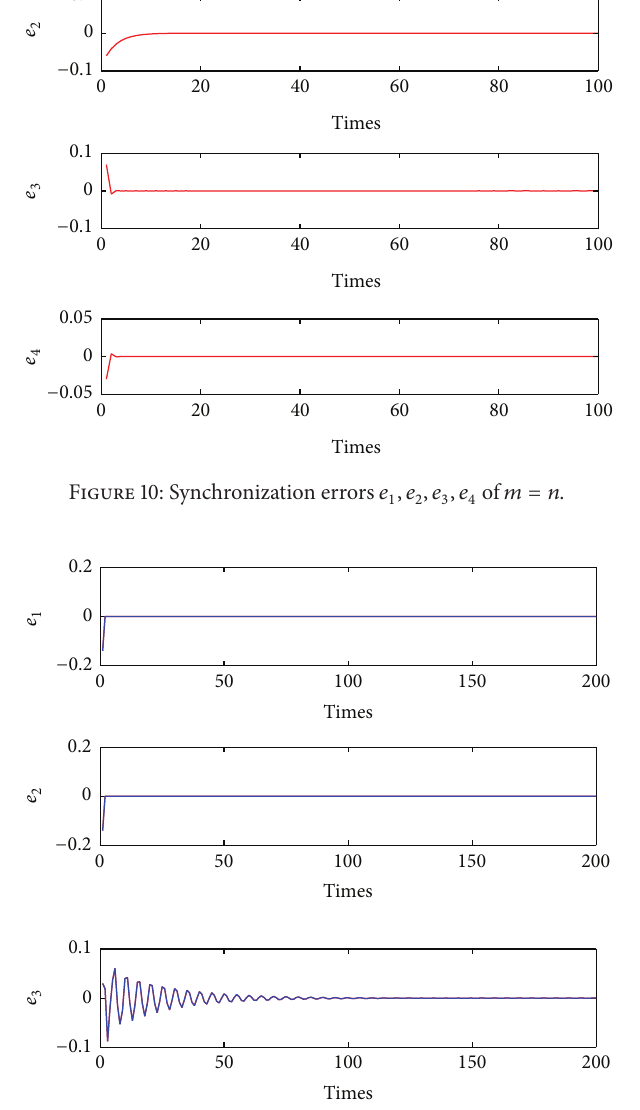
Figure 11: Synchronization errors 𝑒 1 , 𝑒 2 ,𝑒 3 of 𝑛 < 𝑚 .